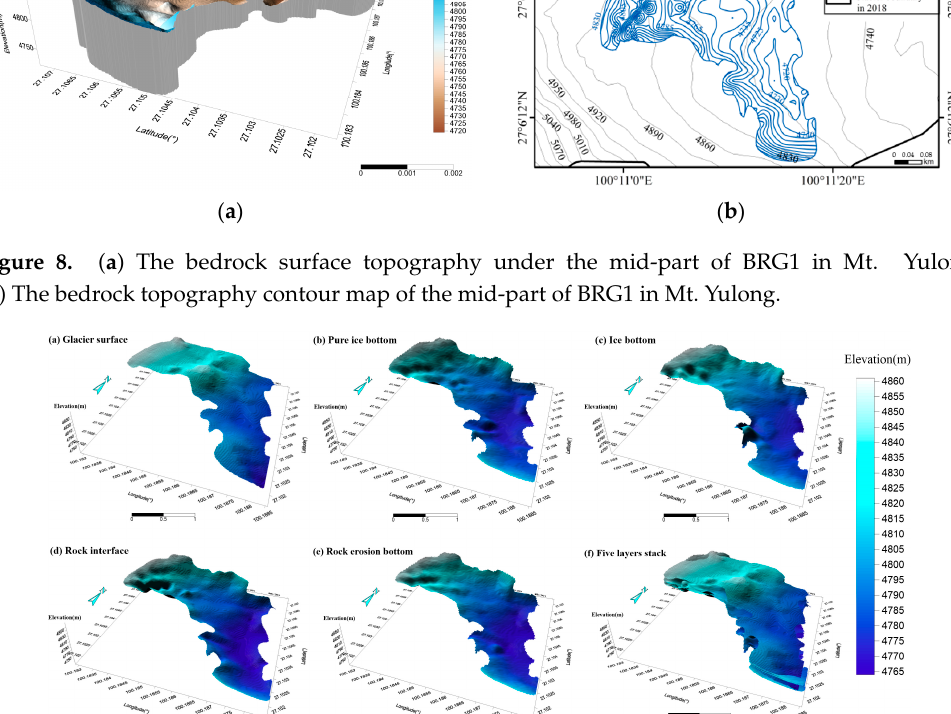
Figure 9. ( a ) Three-dimensional (3-D) image of the glacier surface topography. ( b ) The 3-D image of the pure ice bottom topography. ( c ) The 3-D image of the debris-rich ice bottom topography. ( d ) The 3-D image of the bedrock interface topography. ( e ) The 3-D image of the rock erosion bottom topography. ( f ) The 3-D image of the subglacial five-layer structure stack of the mid-part of BRG1 in Mt. Yulong.